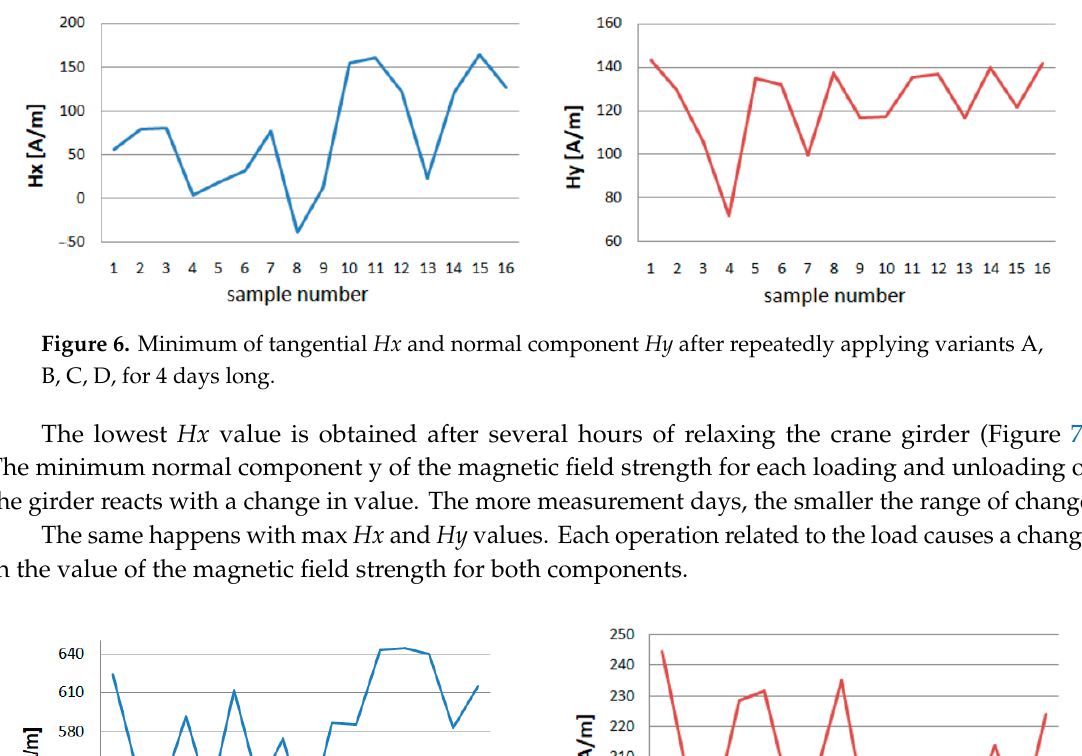
Figure 6. Minimum of tangential Hx and normal component Hy after repeatedly applying variants A, B, C, D, for 4 days long.